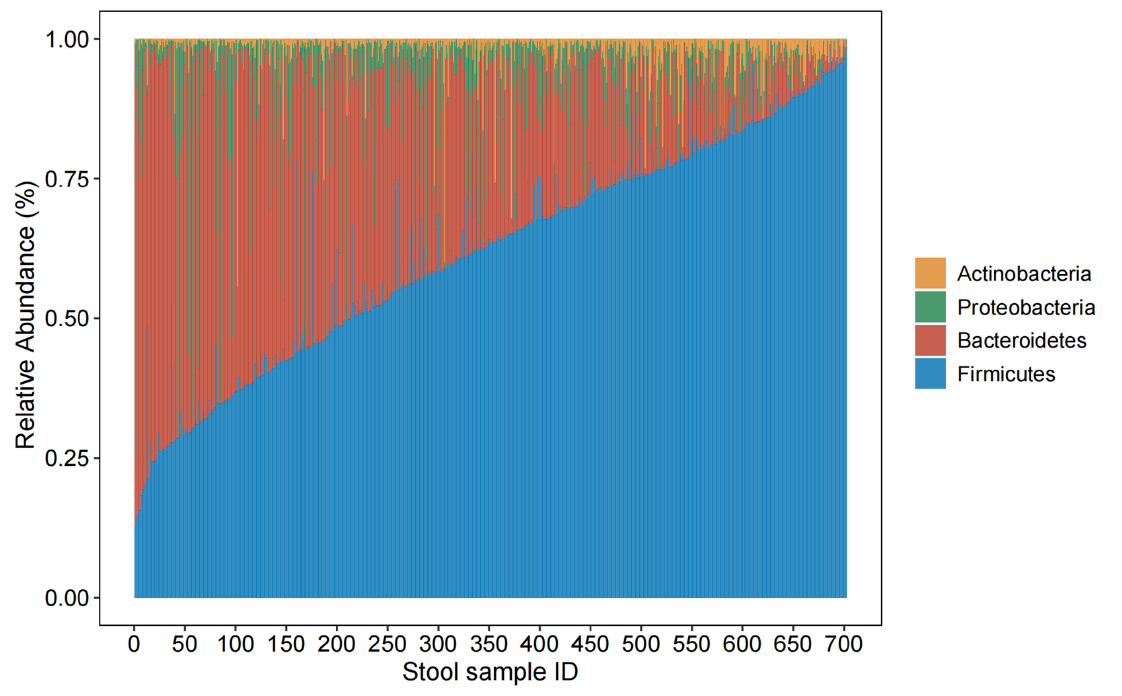
Figure 1. Relative abundances of the 4 most abundant phyla. Each thin vertical bar presents relative